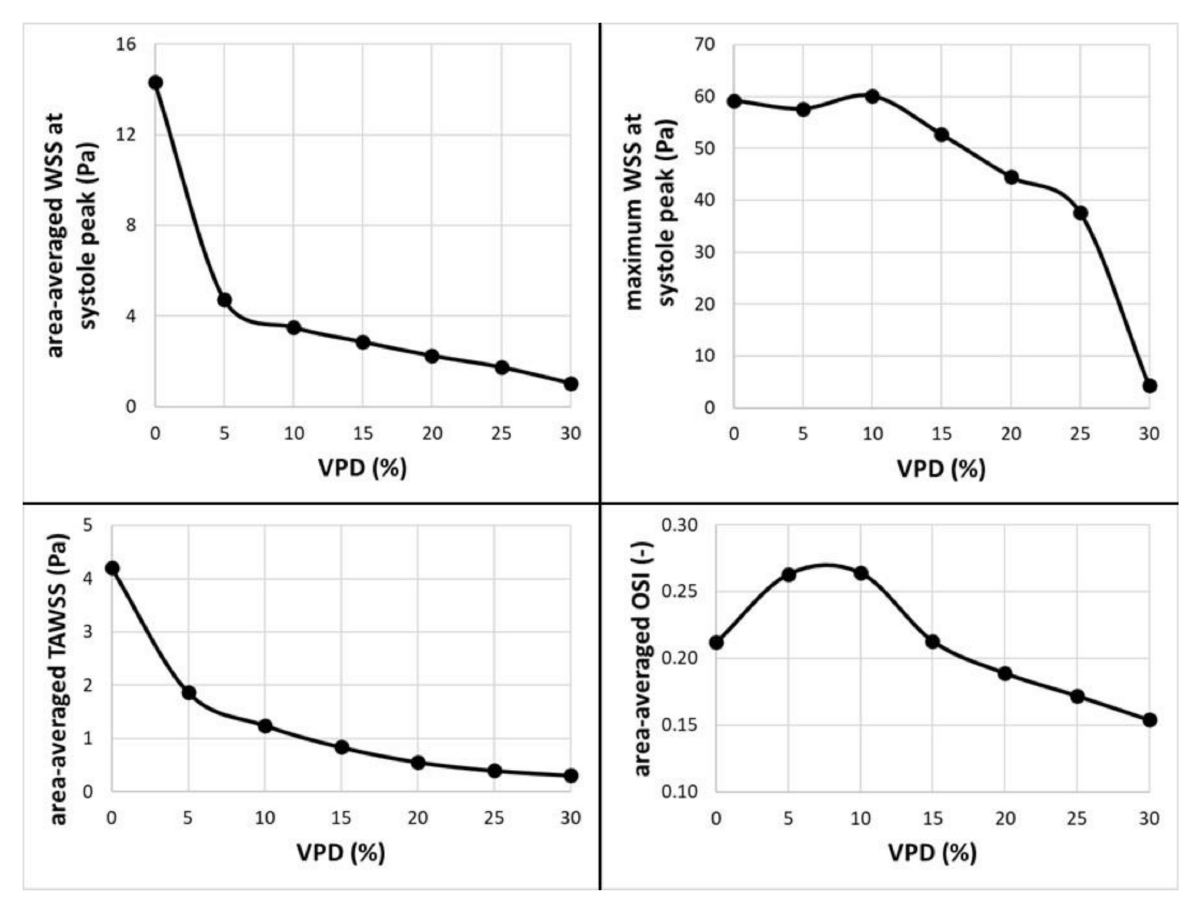
Figure 14. Dependence of selected hemodynamic parameters (at aneurysmal wall) on the 1st coil packing density; tran- sient